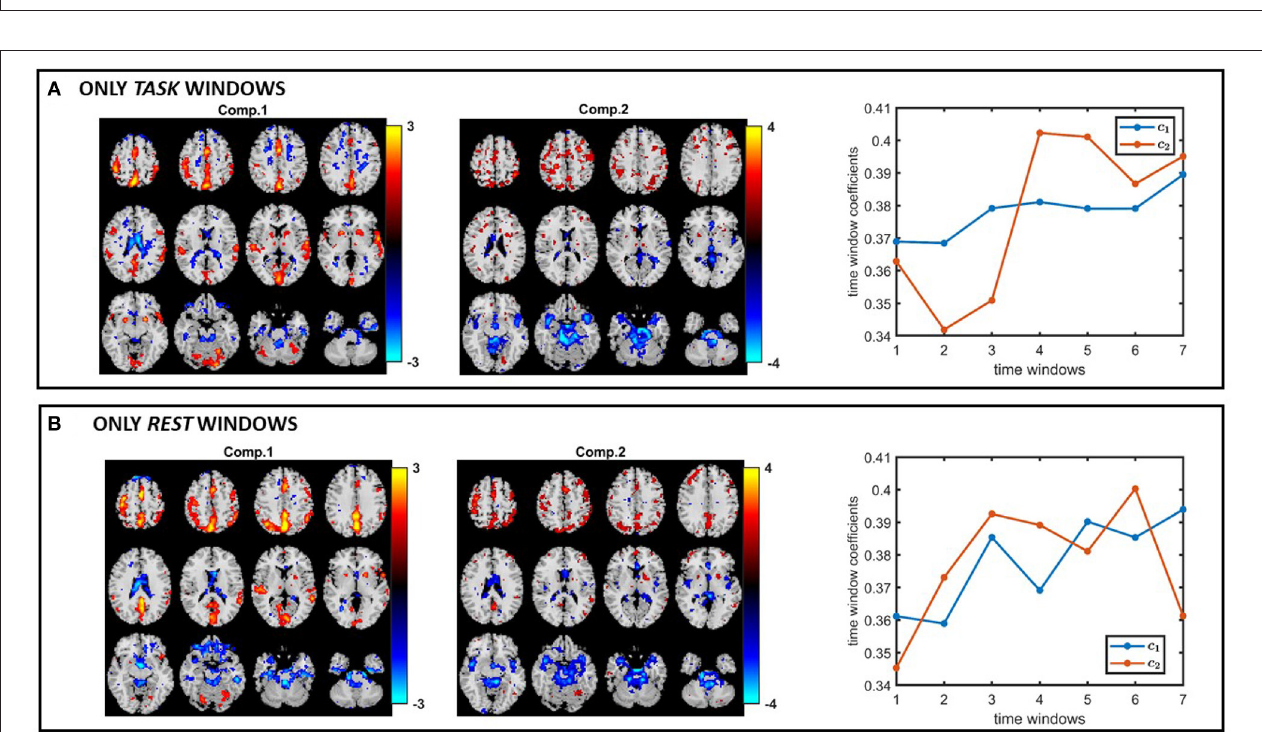
FIGURE 12 | Joint ICA analysis of task fMRI data. Spatial components, i.e., rows of S k . Here, we only plot rows of S 1 corresponding to the first time window. Spatial maps are plotted using the patterns from the voxels mode as z-maps and thresholding at | z | ≥ 1.5 such that red voxels indicate an increase in controls over patients, and blue voxels indicate an increase in patients over controls. The p -values are 1.1 × 10 − 4 for component 1, and 1.4 × 10 − 1 for component 2.